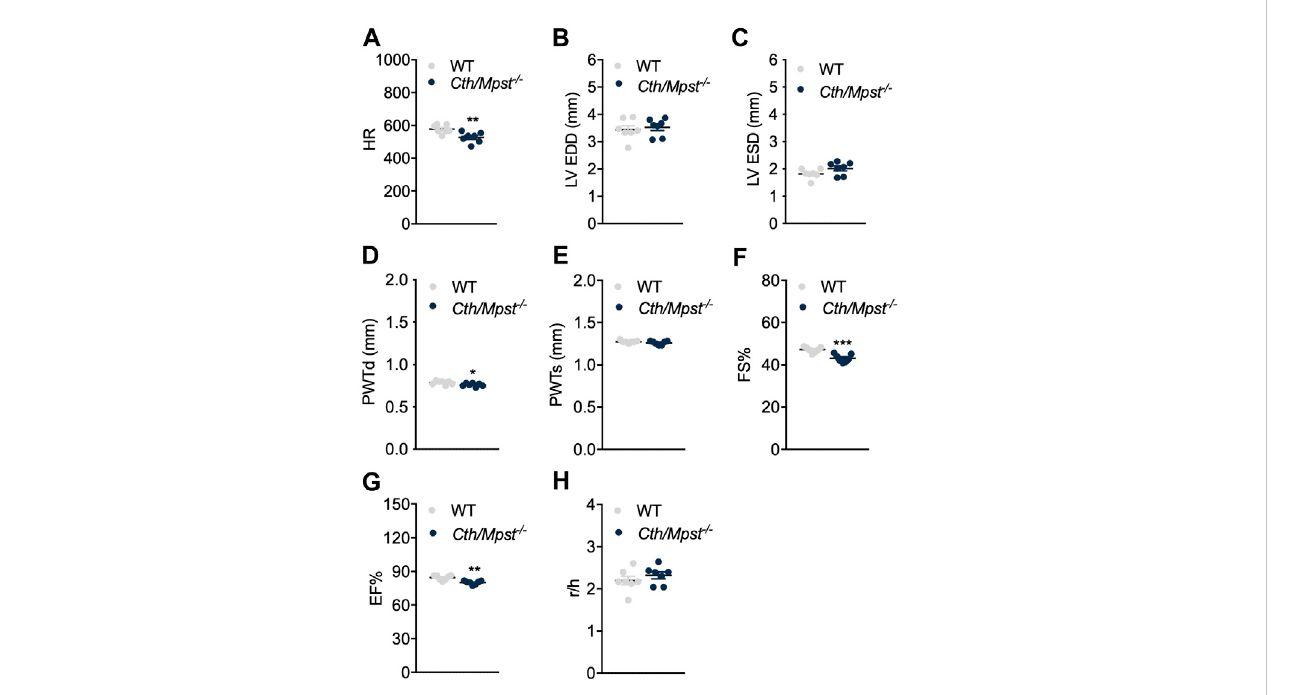
FIGURE 5 Normal cardiac function parameters after the double Cth/Mpst inhibition in mice. (A) Heart rate (HR), (B, C) left ventricular (LV) end-diastolic and end systolicdiameter(LVEDD,LVESD), (D,E) LVposteriorwallthicknessatdiastoleandsystole(PWd,PWs), (F) fractionalshortening(FS%), (G) ejectionfraction(EF) and (H) LV radius to LV posterior wall thickness ratio (r/h) analyzed by echocardiography in WT and knockout mice. Data are presented as means ± S.E.M, *p < 0.05, ** p ≤ 0.01 and *** p ≤ 0.001, N = 7 mice per group.